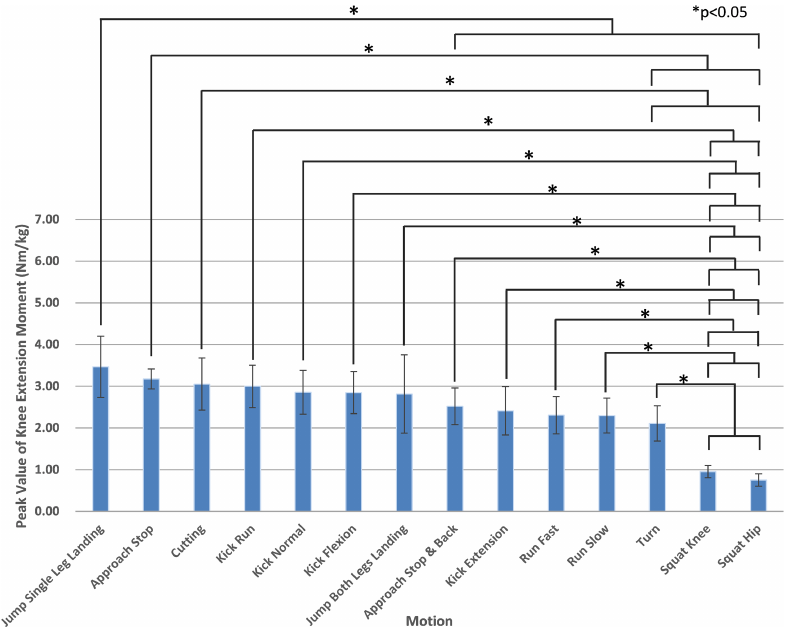
Fig 1. Comparison between motions by test subject mean of peak knee extension moment. Values are shown in descending order from left to right. Multiple comparisons were performed after ANOVA to show statistically significantdifferences betweenthe motions. * P < 0.05.